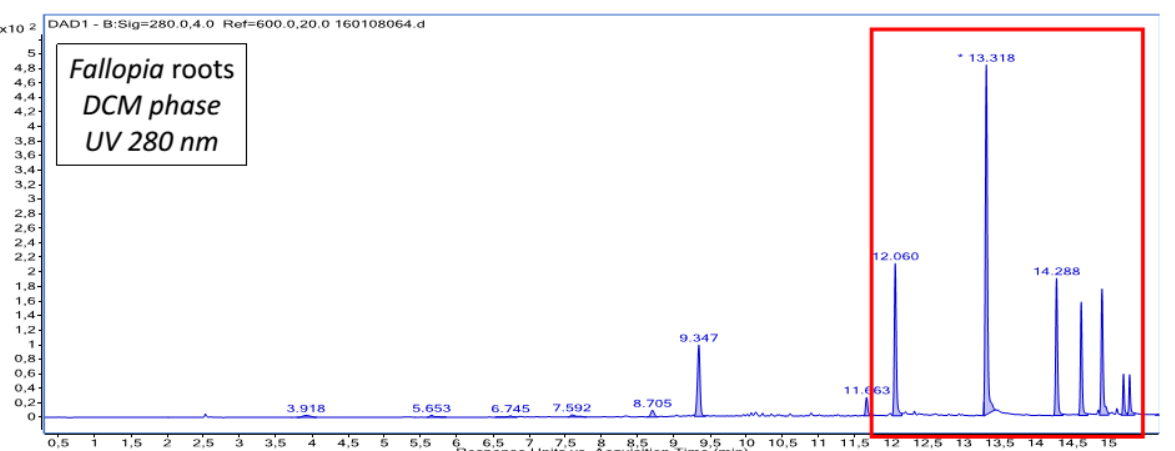
Figure A6. Chemical composition of F. japonica roots aqueous fraction from the tape-strips analysis.